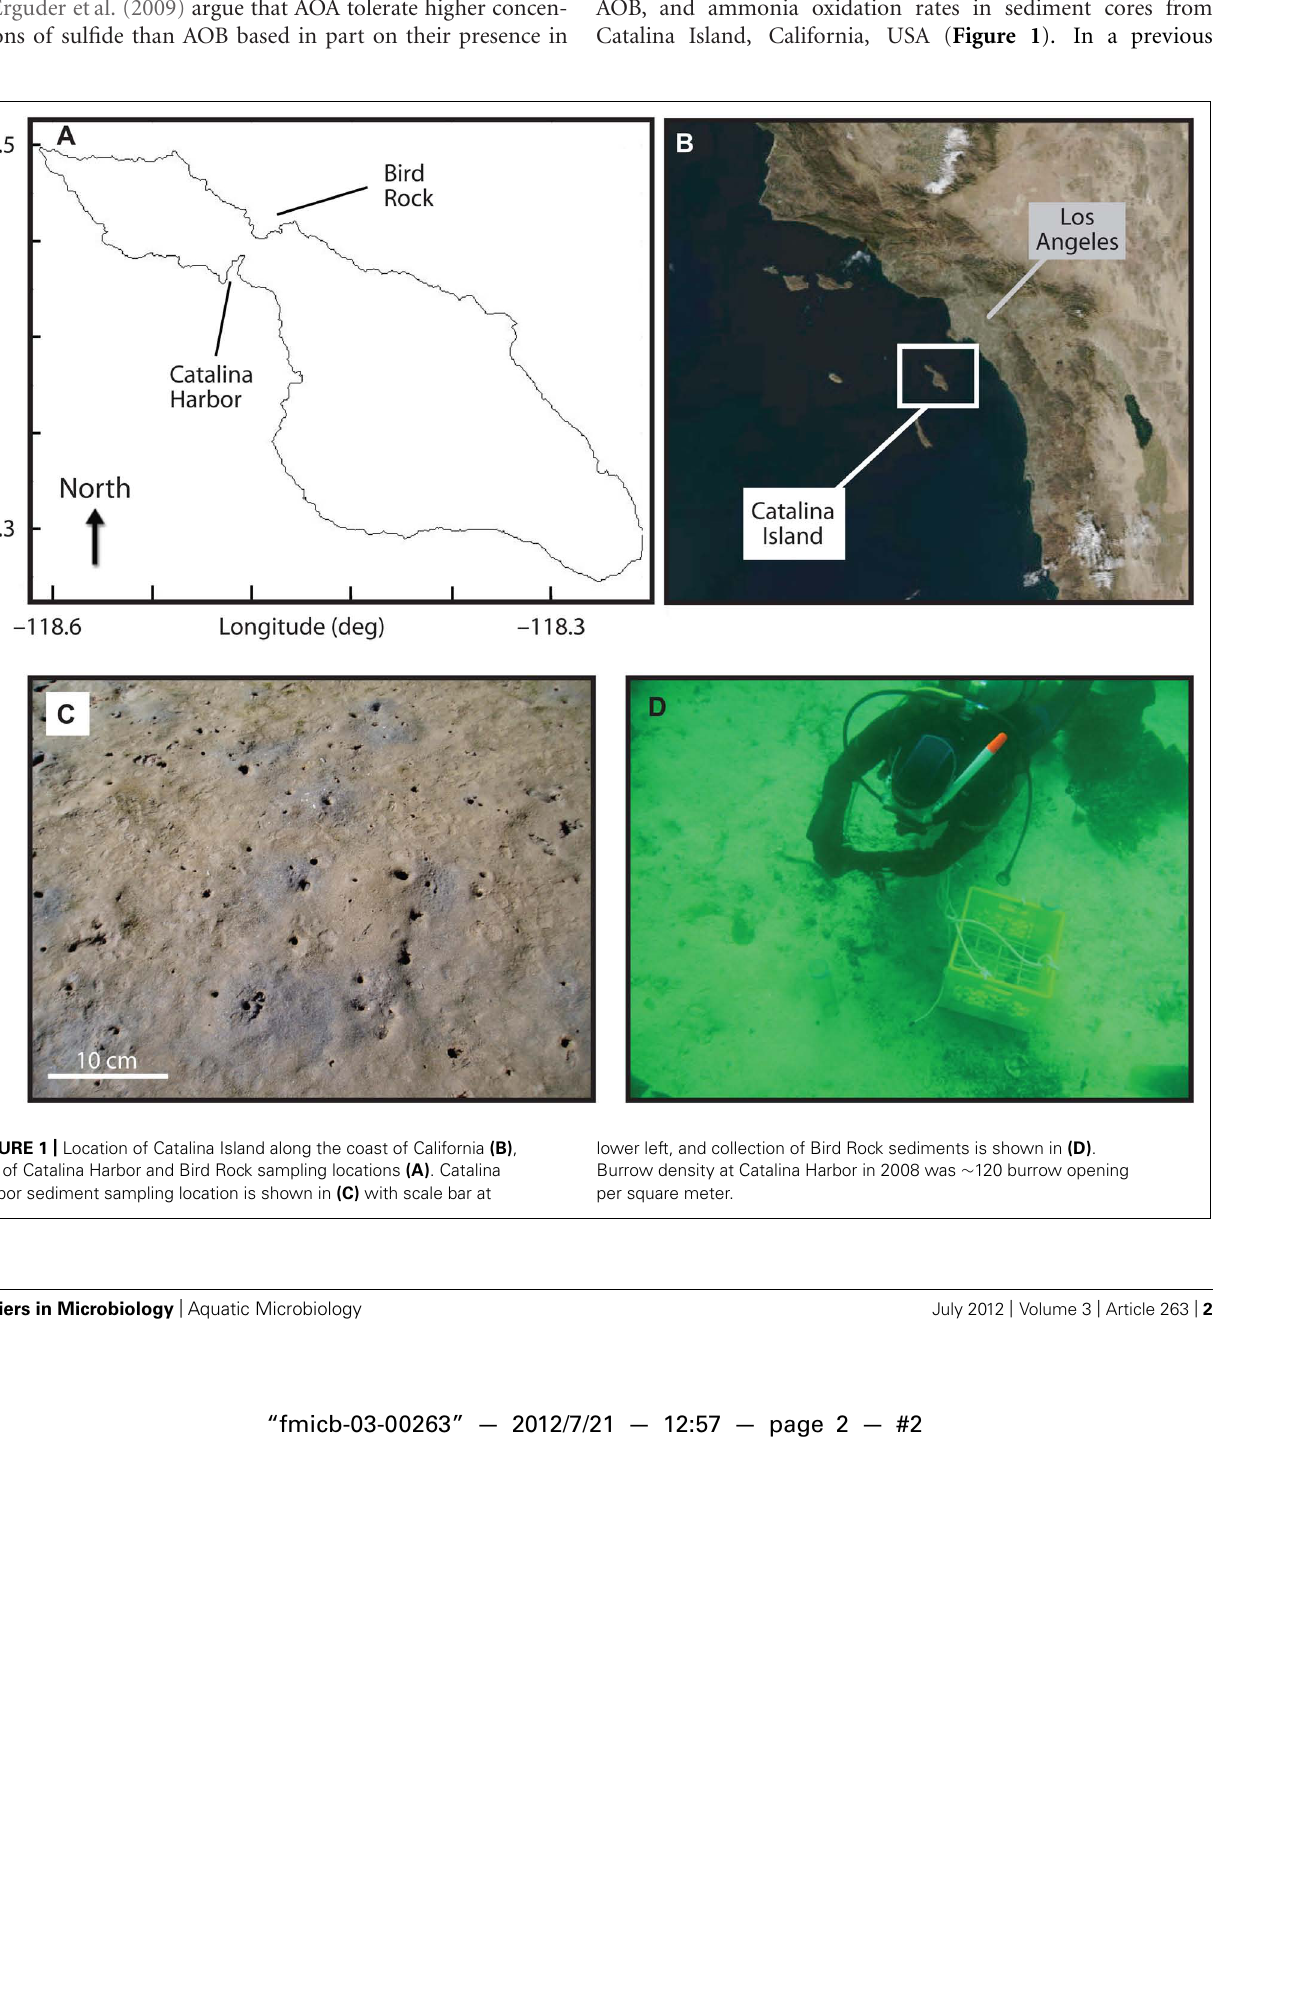
FIGURE 1 | Location of Catalina Island along the coast of California (B) , and of Catalina Harbor and Bird Rock sampling locations (A) . Catalina Harbor sediment sampling location is shown in (C) with scale bar at